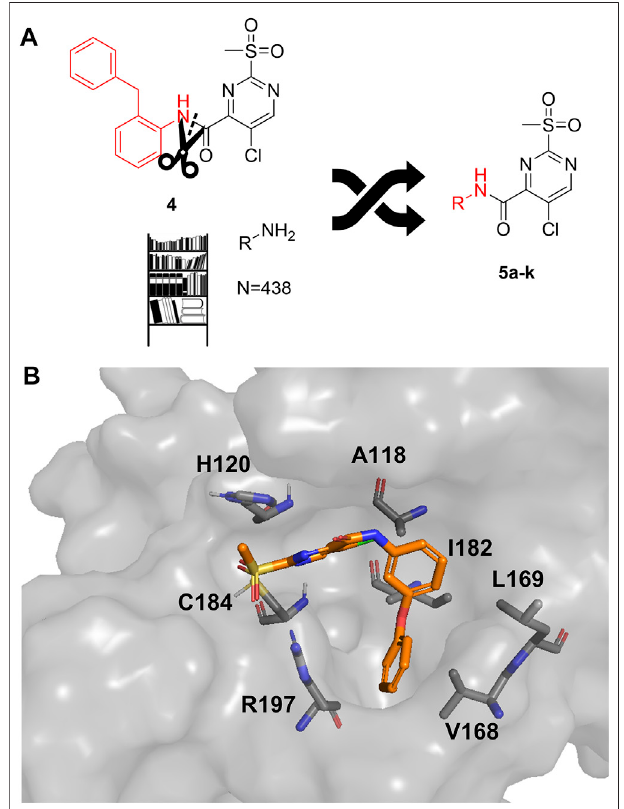
FIGURE2| Optimizationstrategyoverview. (A) Virtualsynthesisstrategy to optimize the inhibition properties of parent compound 4 by synthesis of the sulfonylpyrimidines 5a – k . Carboxylic acid 5c was coupled in silico with 438 aminesand theresulting amidesweredocked intoareceptor ofthe SrtA active site. Subsequently, virtual screening hits 5a – k were synthesized. (B) Docking pose of virtual screening hit 5a with the labeling of interacting residues in the SrtA binding pocket (pdb: